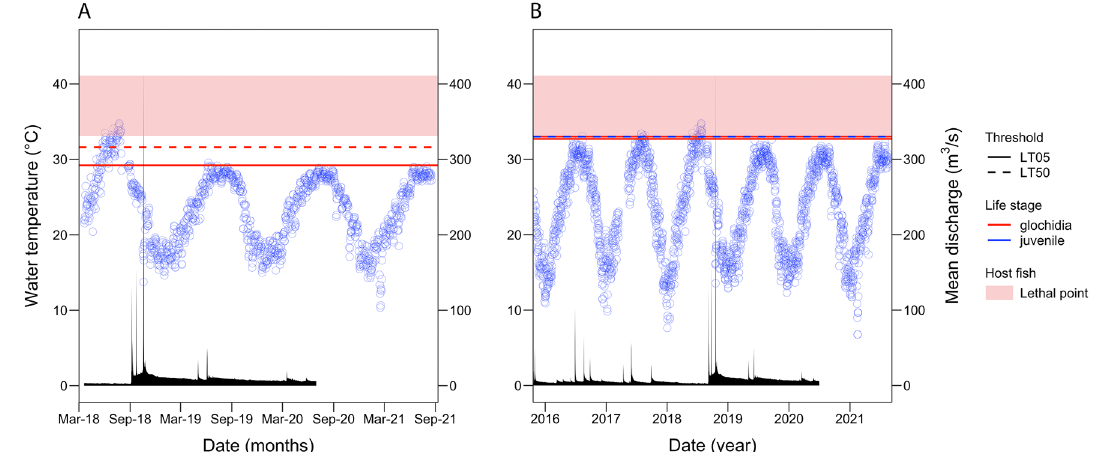
Figure 5. Water temperature and discharge data from two sites in the Devils River overlaid with thermal tolerance data for P. popeii and its host fish. Blue circles = maximum daily water temperature, black polygon = mean daily discharge, red lines = thresholds for glochidia, blue lines = thresholds for juveniles, solid lines = LT05, dashed lines = LT50, and pink rectangle = host fish lethal tolerance range. ( A ) Comparison of maximum daily water temperature at Grass Patch from March 2018 to August 2020 to laboratory derived thermal tolerance of Grass Patch P. popeii and its presumptive host fish. ( B ) Comparison of maximum daily water temperature at Ruthies from October 2015 to August 2020 to laboratory derived thermal tolerance of Ruthies P. popeii and its presumptive host fish.